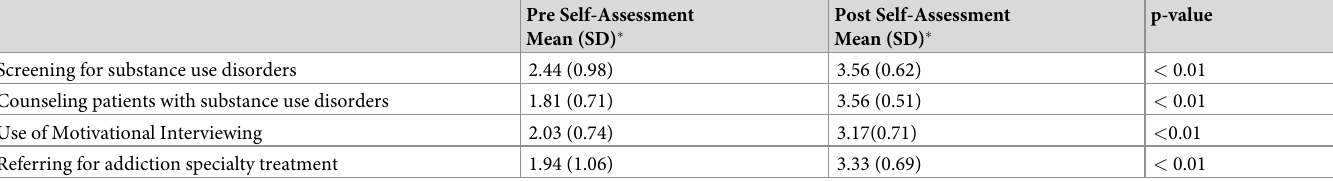
Table 3. Resident clinical skills self-assessments before and after completion of the pilot SUD curriculum (N =